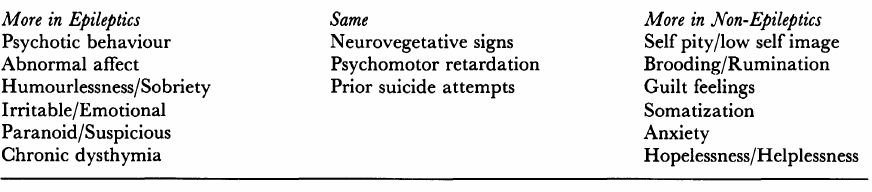
Characteristics of depressed epileptic patients compared with depressed non-epileptic patients More in Epileptics Psychotic behaviour Abnormal affect